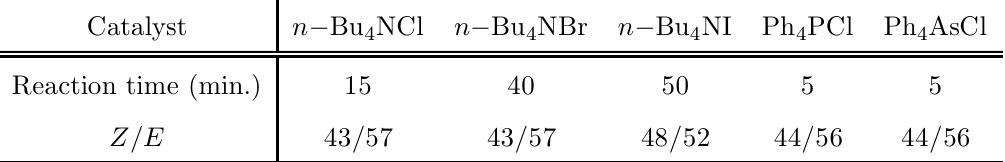
Table 6 The in®uence of an equimolecular quantity of the catalyst under the speci› ed PTC conditions: NaOH 0,2 N/CH 2 Cl 2 , 25 o